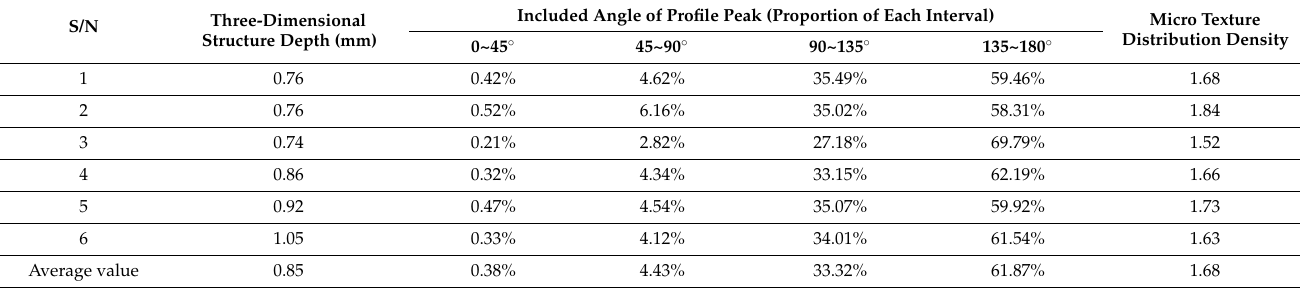
Table 6. Results for EA-10C laser texture detection. S/N